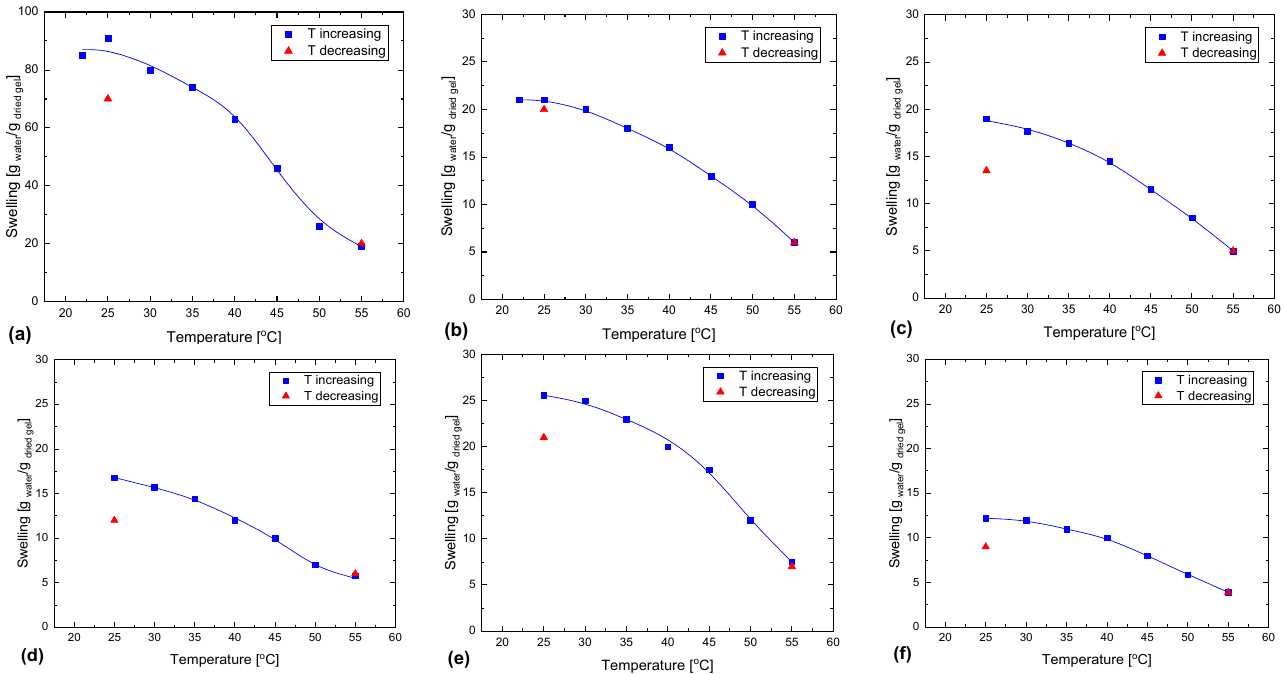
Figure 7. Temperature-dependent swelling of HPC hydrogels containing PEGDA; HPC%/PEGDA% composition: ( a , b ) 20/0; ( c ) 20/2.5, ( d ) 20/5, ( e ) 10/2.5, and ( f ) 10/5. Gels produced with 50 kGy, except ( b ): 100 kGy.